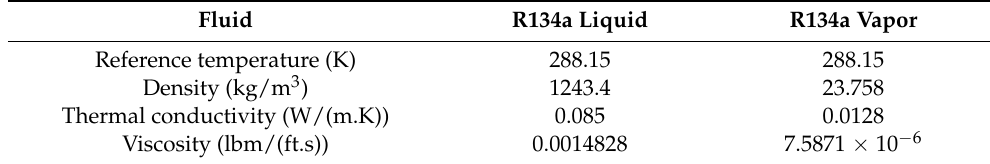
Table 1. The properties of the working fluid.